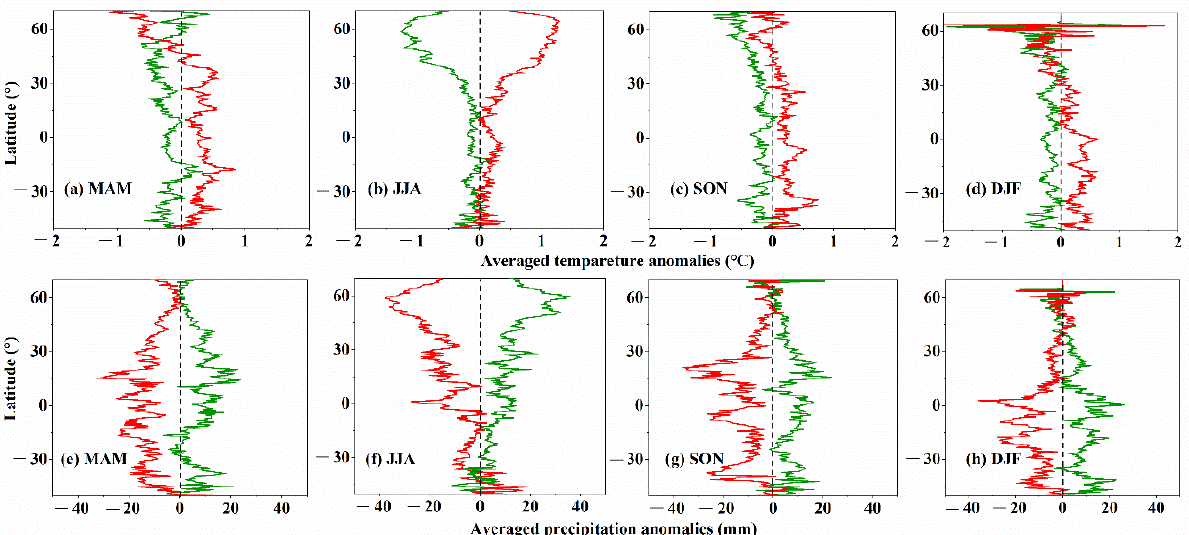
Figure 8. The averaged ( a–d ) temperature and ( e–h ) precipitation anomalies in positive (green line) and negative (red line) CUE extremes pixels at different latitudes in the four seasons. “MAM” contains the month of March, April, and May; “JJA” contains the month of June, July, and August; “SON” contains the month of September, October, and November; “DJF” contains the month of December, January, and